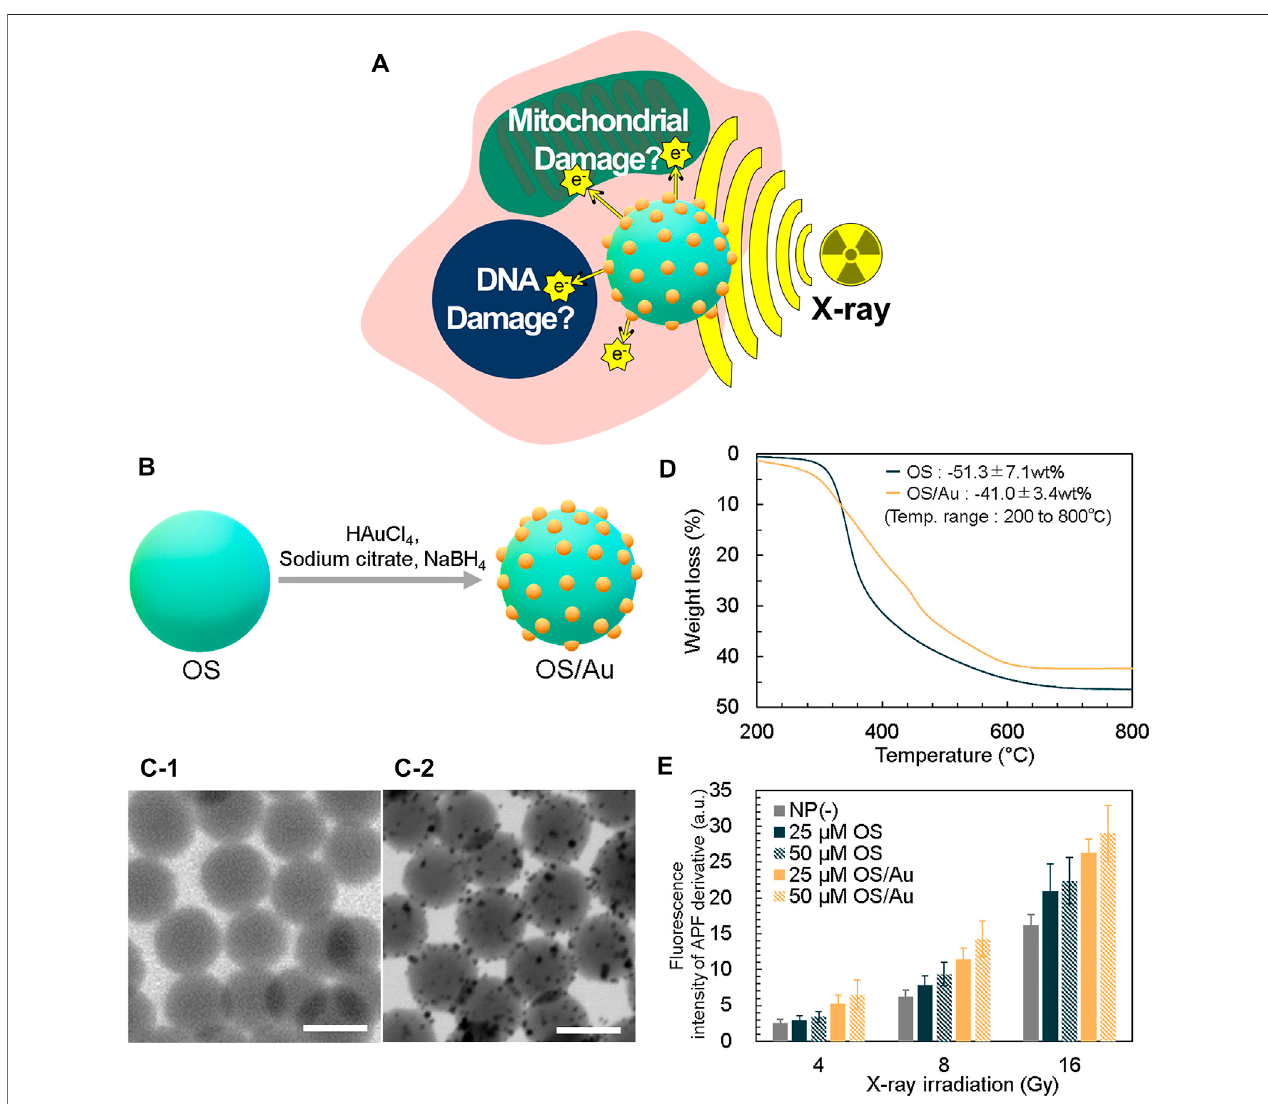
FIGURE 1 | Strategy for X-ray sensitizer and characterization of OS/Au. (A) Schematic of the strategy for X-ray sensitizer as cancer cell therapy. (B) Detailed overviewofthesurfacefunctionalizationofOSwiththeAuNPs(OS/Au)ofOS/Au.TheSTEMofOS(C-1)and OS/Au(C-2). Scalebar =100 nm. (D) TGAdataofOSand OS/Au. (E) Fluorescence intensity of the APF